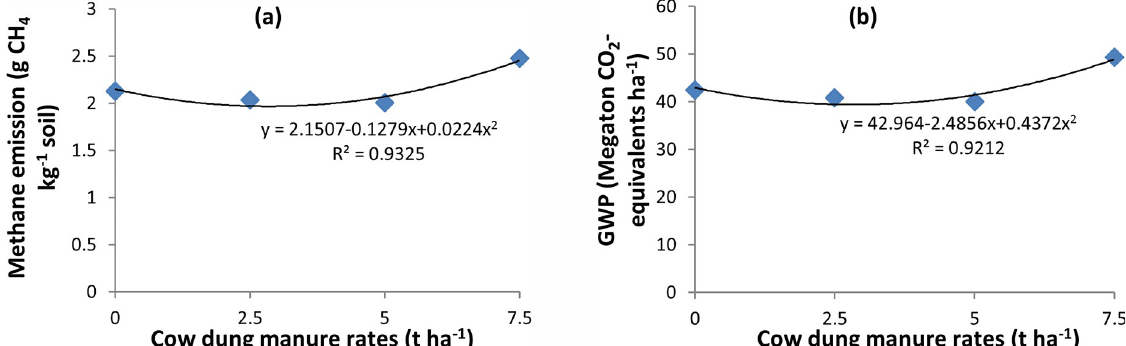
Fig 12. Relationship between methane emission and different cow dung manure rates (a) and between GWP and different cow dung manure rates (b) in dry season, 2017.